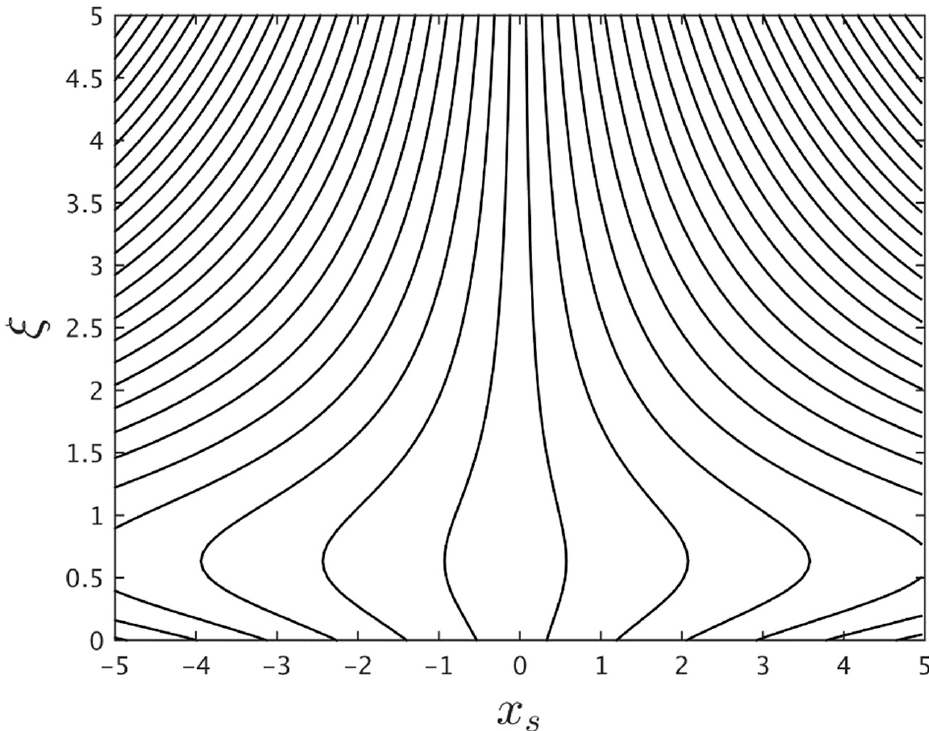
Figure 18. Plot of streamlines for the upper branch solution when M c = 0.5.